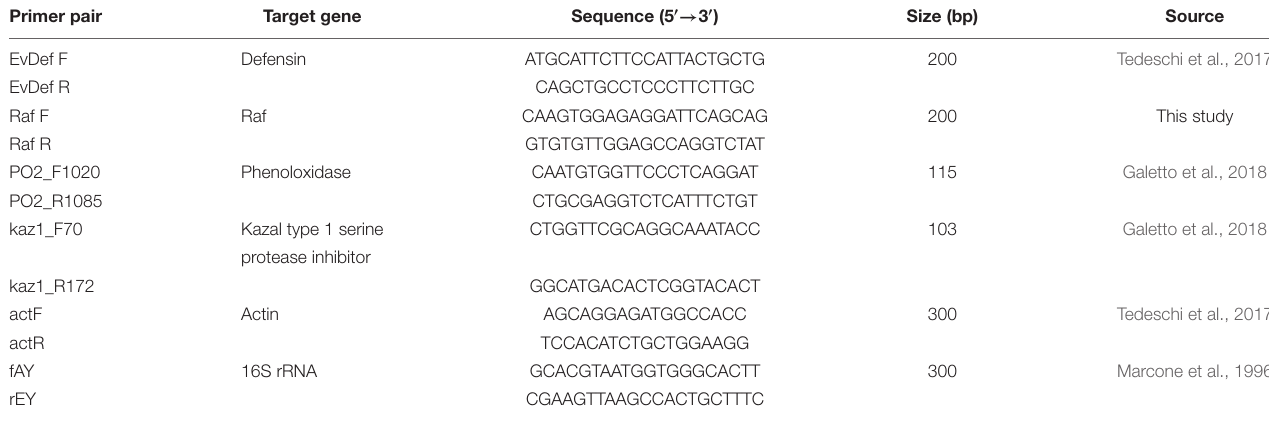
TABLE 1 | Primers used in this study. Primer pair Target